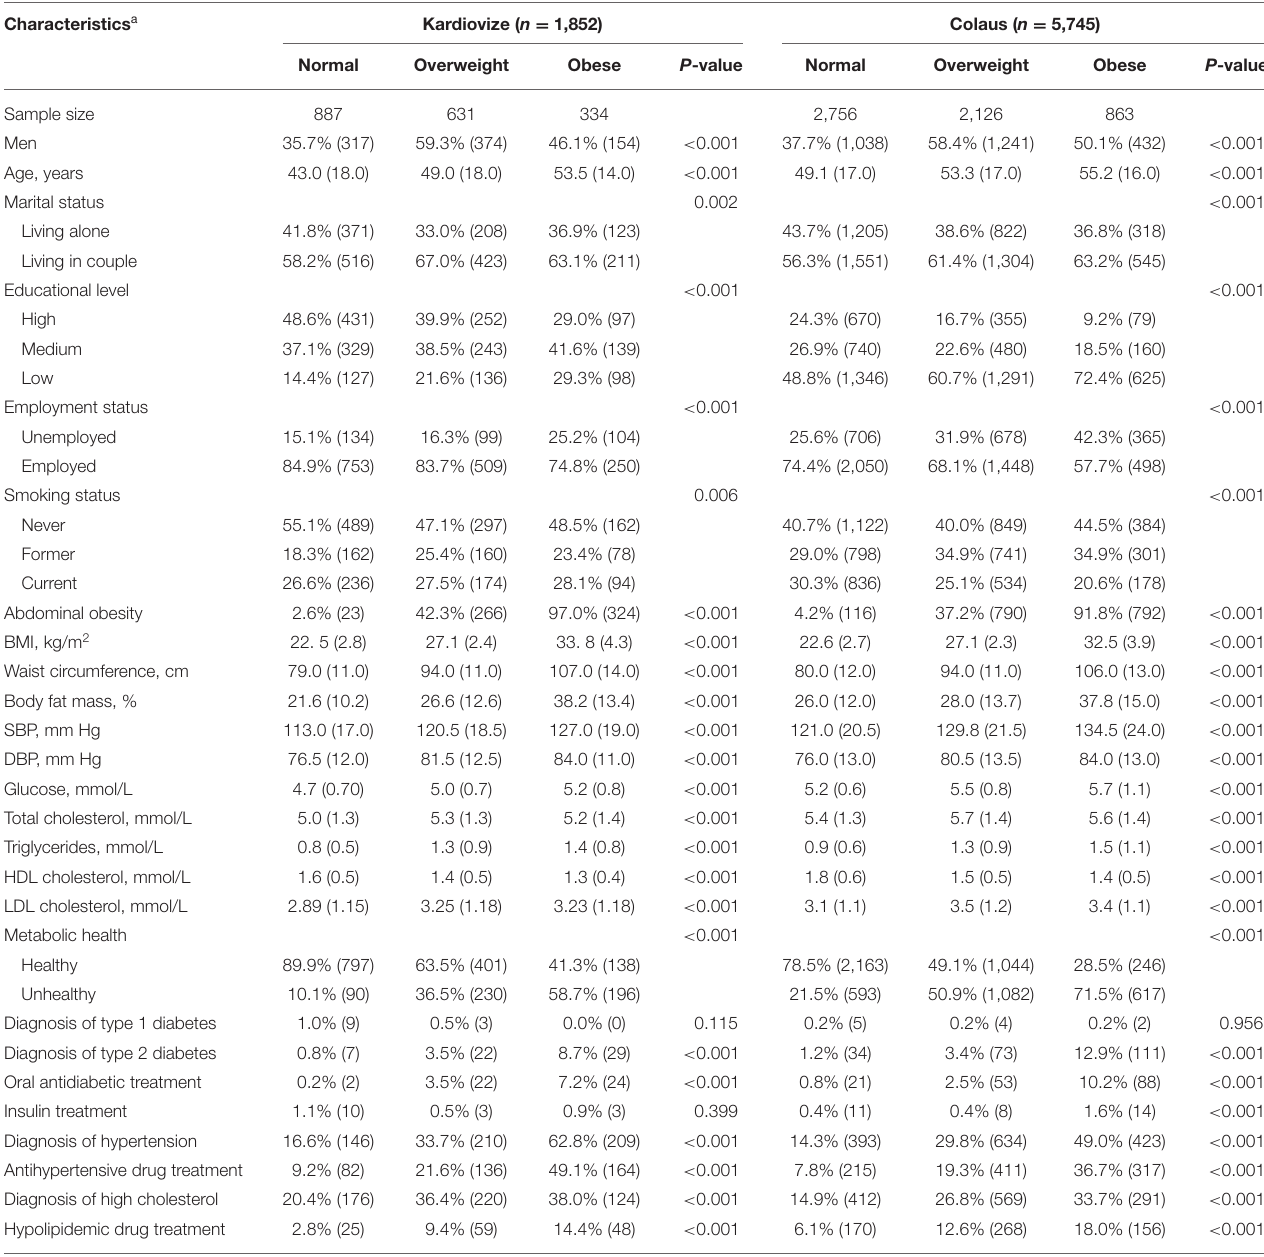
TABLE 1 | Characteristics of participants according to BMI categories. Characteristics a Kardiovize ( n = 1,852) Colaus ( n = 5,745) Normal Overweight Obese P -value Normal Overweight Obese P